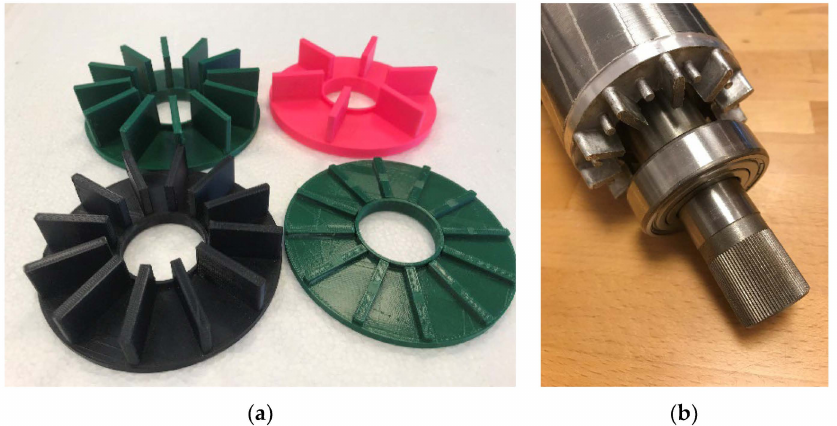
Figure 3. ( a ) Three-dimensionally printed ventilation fans with different blade configurations; ( b ) die casted blades as an integral part of the rotor end ring of an induction machine.